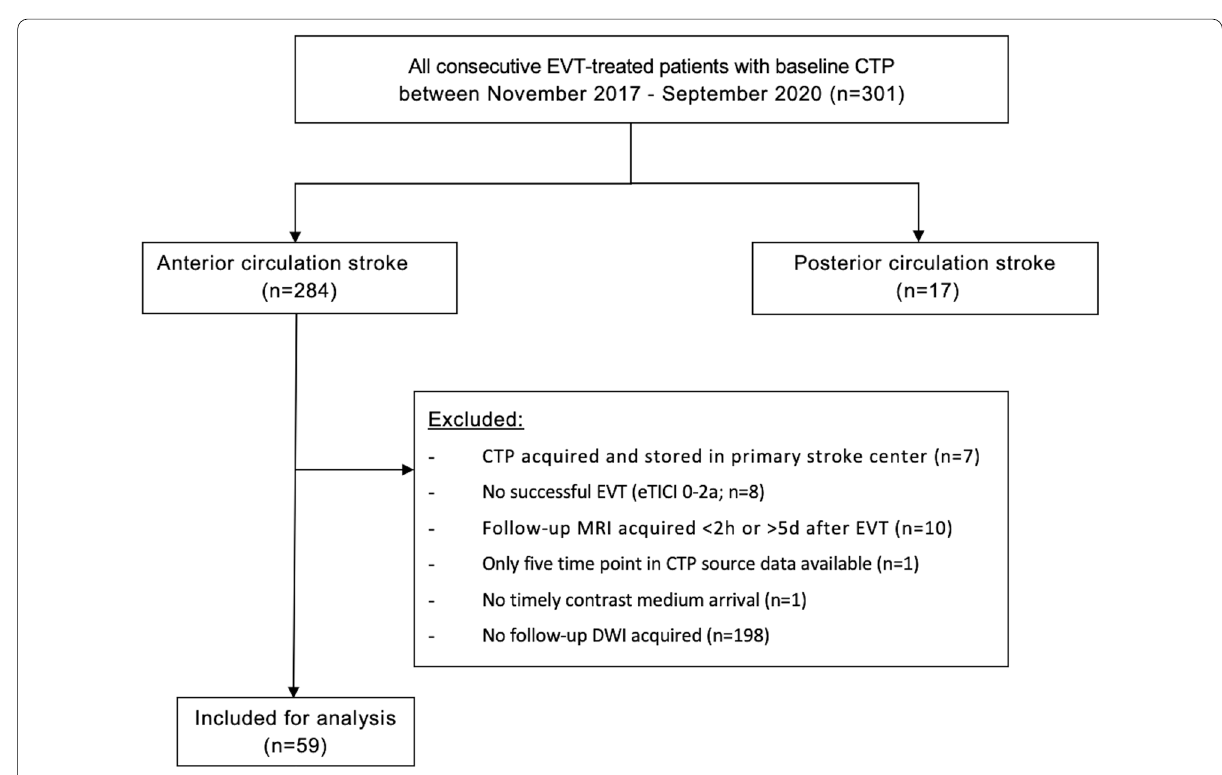
Fig. 1 Flowchart of patient